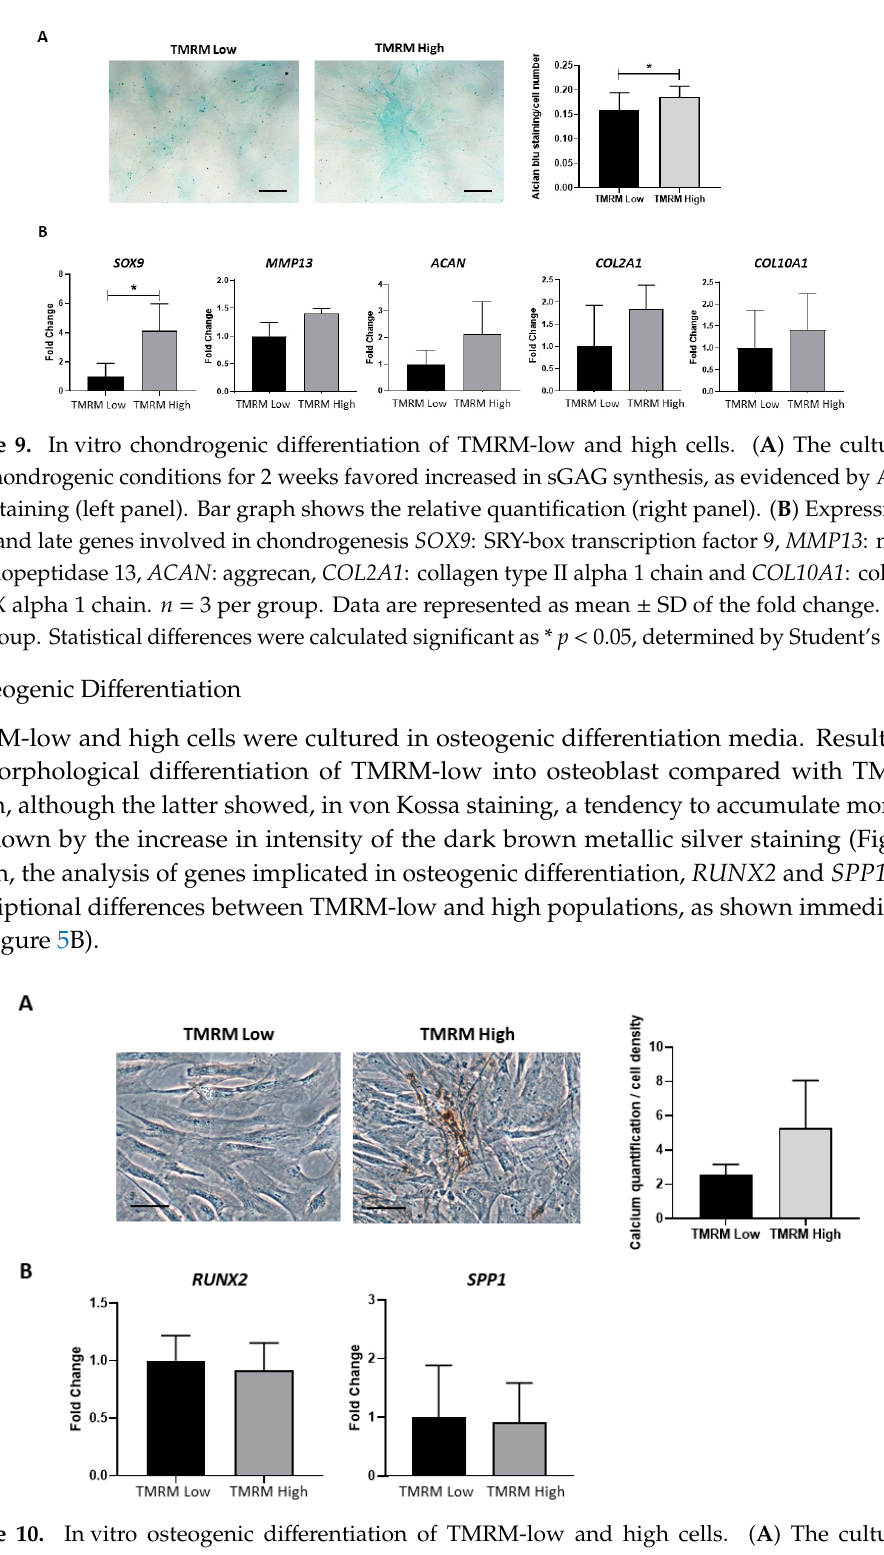
Figure 10 . In vitro osteogenic differentiation of TMRM-low and high cells. ( A ) The culture in pro- pro-osteogenic conditions for 1 week enhance the expression of calcium salts, although not significantly (left panel). The bar graph shows the relative quantification (right panel). ( B ) Expression of genes involved in osteogenesis RUNX2 : runt-related transcription factor 2, SPP1 : secreted phosphoprotein 1. Data are represented as mean ± SD of the fold change. n = 3 per group. Statistical di ff erences were determined by Student’s t